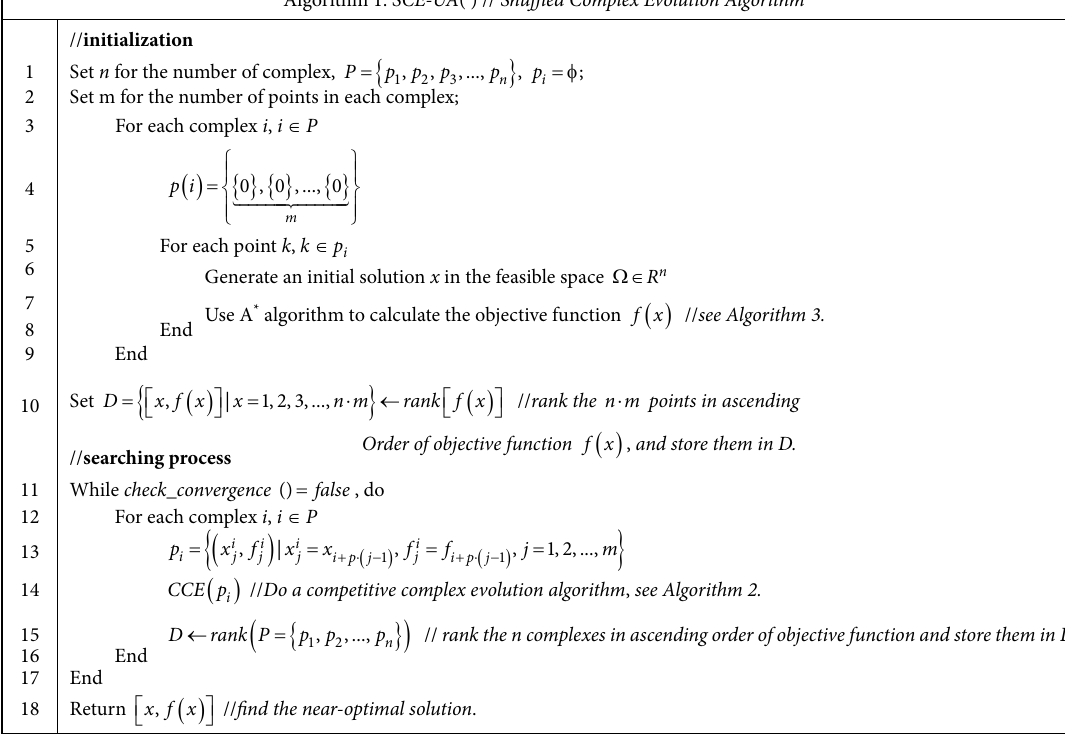
Algorithm 1: SCE-UA ( ) // Shuffled Complex Evolution